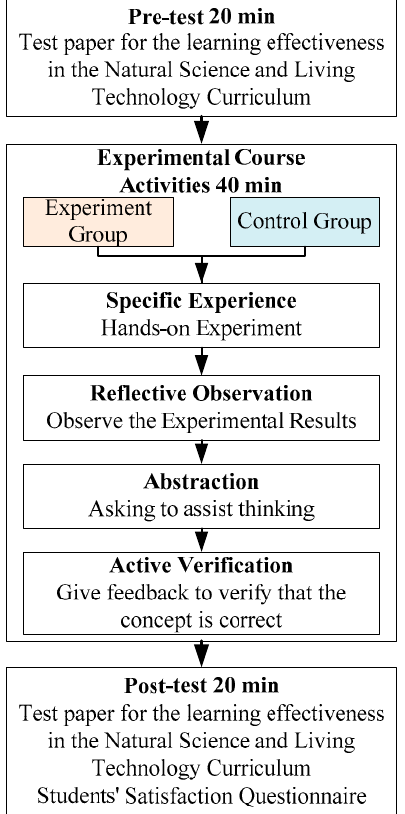
Figure 3. Flow chart of the experimental activity in this study.